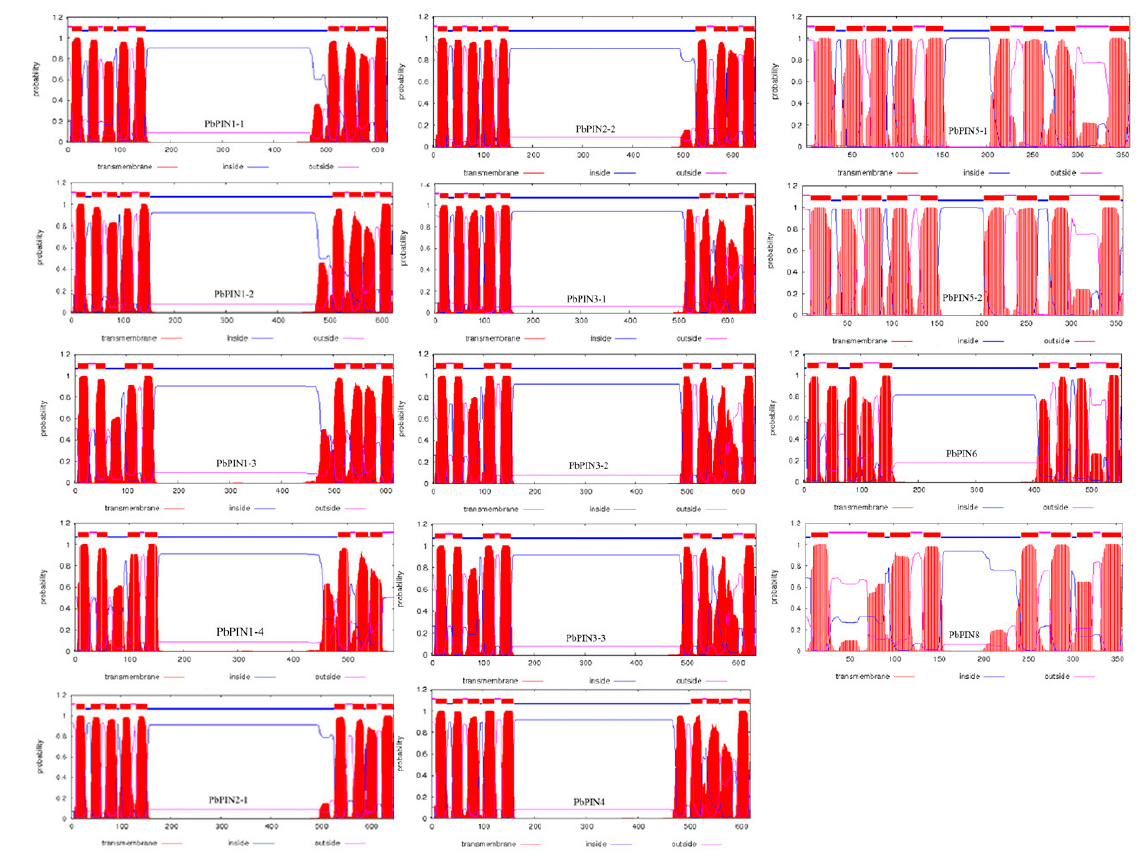
Figure 4. Transmembrane topology analysis of pear PbPIN proteins. The protein transmembrane topology was predicted by using the TMHHM Server v2.0. The predicted transmembrane helices are shown as red peaks.